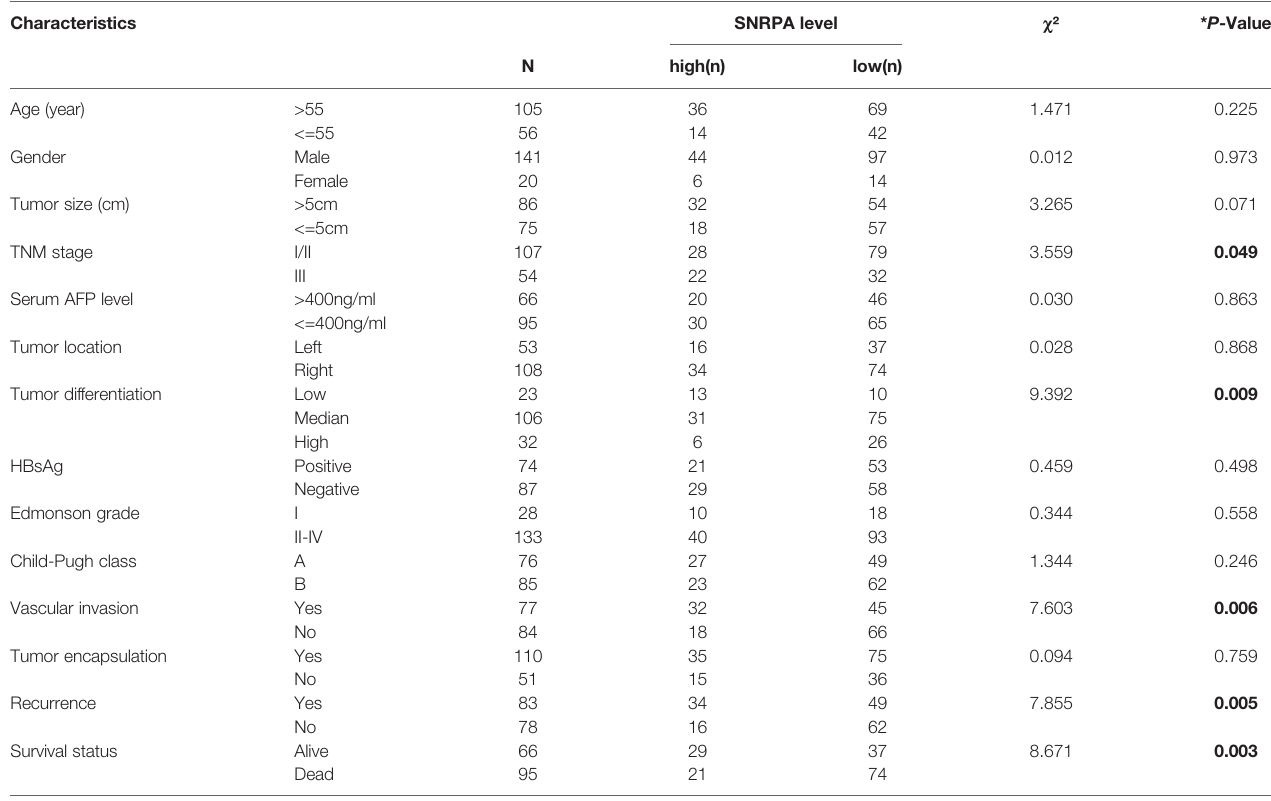
TABLE 1 | Correlation between SNRPA protein expression and clinicopathologic features in 161 patients with hepatocellular carcinoma. Characteristics